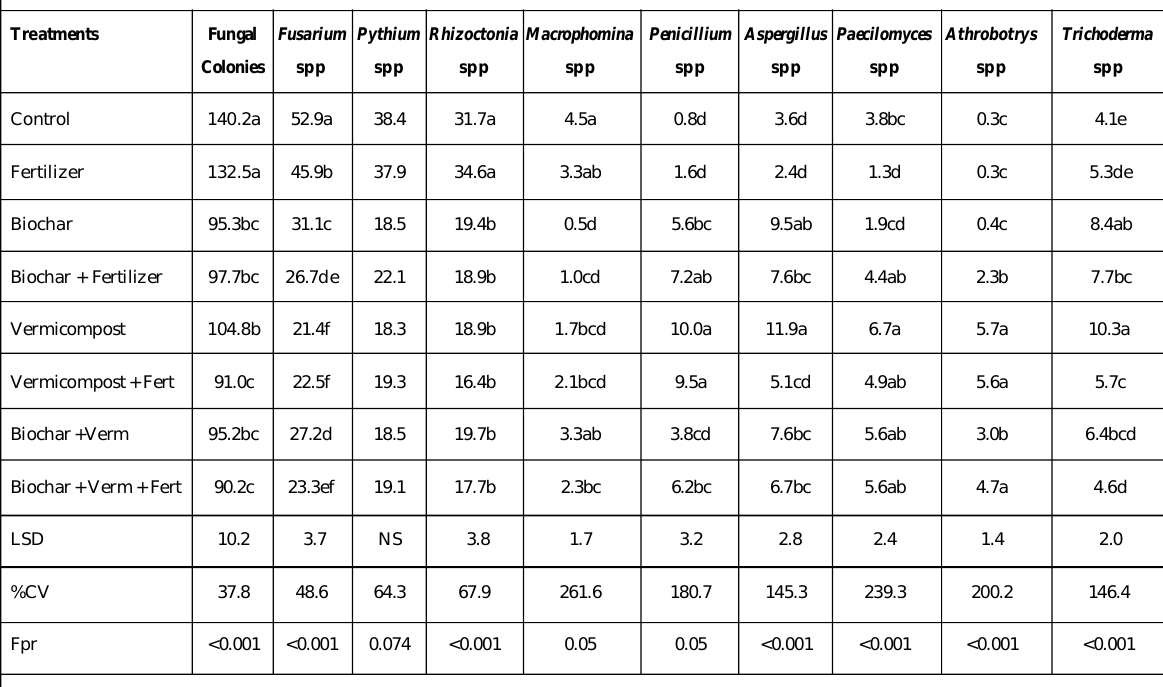
Table 10: Effect of biochar and vermicompost on fungal populations ( × 10 3 CFU/g soil) two weeks after planting common bean in the long rains season of 2014